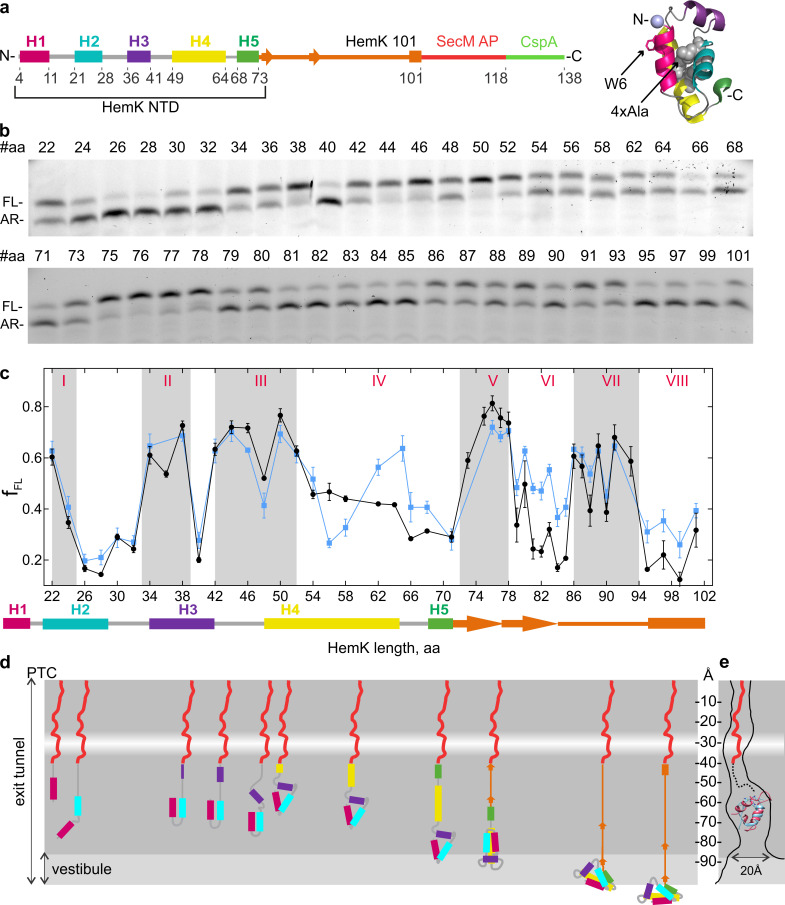
Co-translational folding of HemK NTD revealed by high-resolution FPA.(a) Schematic representation of the FPA sensor. HemK NTD helices (H) 1–5, the C-terminal linker (orange), SecM arrest peptide (red), and CspA (green) (left) and crystal structure of HemK NTD (PDB ID: 1T43) (right). The mutations introduced in the 4xA variant (L27A, L28A, L55A, L58A) are shown in gray and the N-terminal fluorophore position is shown in lilac. (b) SDS-PAGE of in vitro translation products for the FPA construct of wt HemK. The length of the nascent chain from the N-terminus to SecM AP is indicated (#aa). FL, full-length product; AR, arrested peptide. For controls with shorter nascent chains, see Figure 1—figure supplement 1d. (c) Force profile of HemK NTD folding. fFL is the fraction of the full-length product formed during in vitro translation. Black, HemK wt; blue, HemK 4xA mutant; error bars indicate standard error of mean calculated from three independent biological replicates (N = 3).The schematic underneath shows the potential secondary structure of HemK at the indicated aa chain length. (d) Schematic diagram of HemK NTD compaction events during translation; color code as in (a). The constriction site is indicated by a white band. (e) Schematic overlay of the HemK H1-H3 crystal structure (pink) (PDB ID: 1T43) and ADR1 Zn finger domain crystal structure (blue) inside the peptide exit tunnel, 60–80 Å from the PTC (Nilsson et al., 2015) (PDB ID: 2ADR; EM map: EMD-3079).Figure 1—source data 1.Numerical values of HemK wt and 4xA variant FPA f_FL.